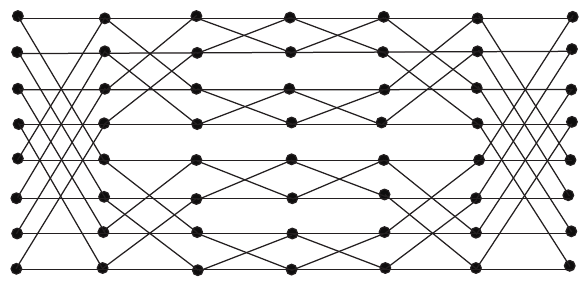
Figure 1: 3-dimensional Benes